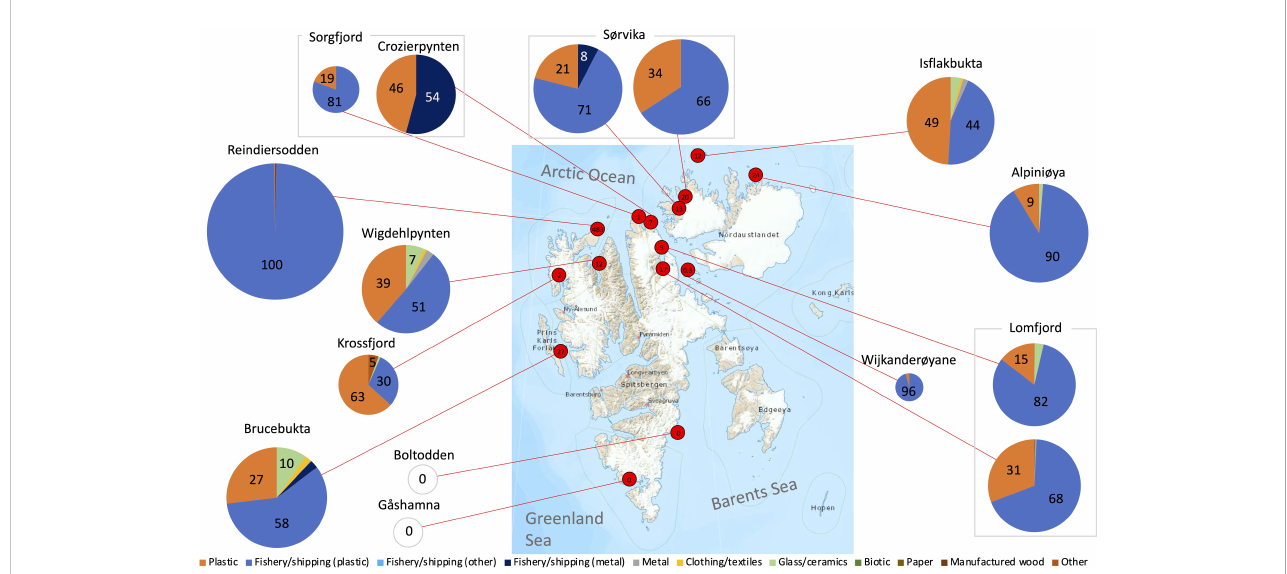
FIGURE 3 Map of all locations of beach debris surveys (mass) depicted by red dots with the mass in g m -2 , which is also scaled by the relative size of pie charts showing the rounded proportions [%] of debris categories. Log (x+1)-transformed mass was used to improve the graphic representation (Map © Norwegian Polar